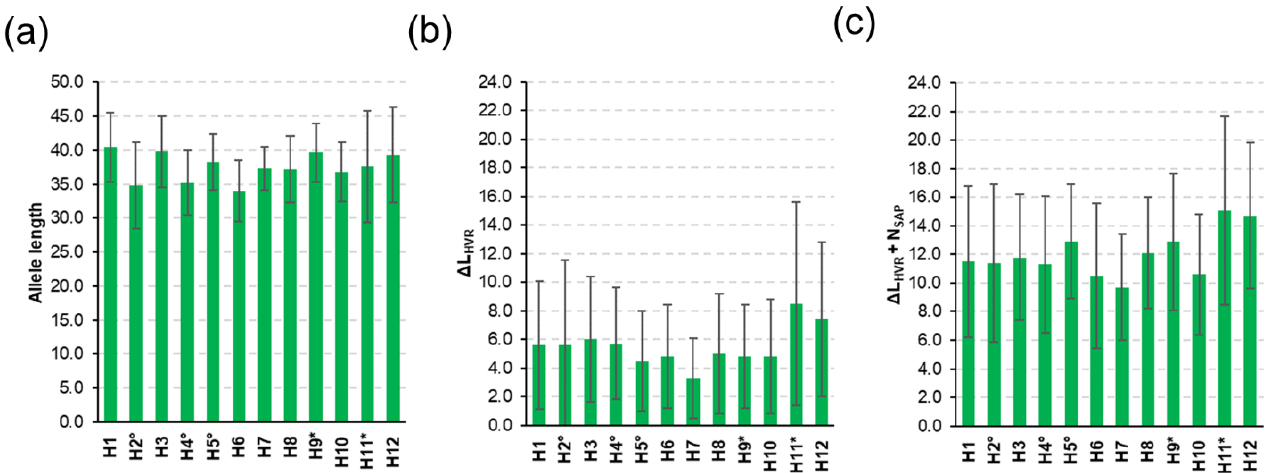
Figure 1. Study of the within sample HVR csd variability. ( a ) Allele length (mean ± s.d.); ( b ) Δ L HVR (mean ± s.d.); ( c ) Total differences ( Δ L HVR + N SAP ; mean ± s.d.). ° Samples belonging to the same beekeeper. * Samples belonging to the same beekeeper.